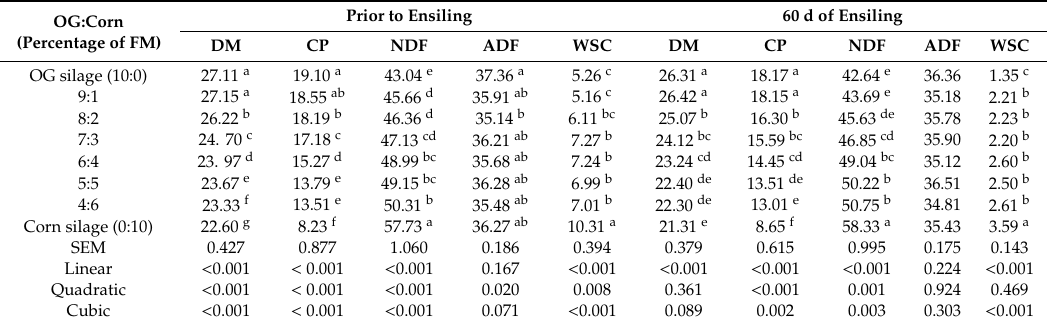
Table 2. Chemical compositions (% DM) of Oxytropis glabra (OG) mixed with whole-plant corn at di ff erent ratios prior to and after 60 d of